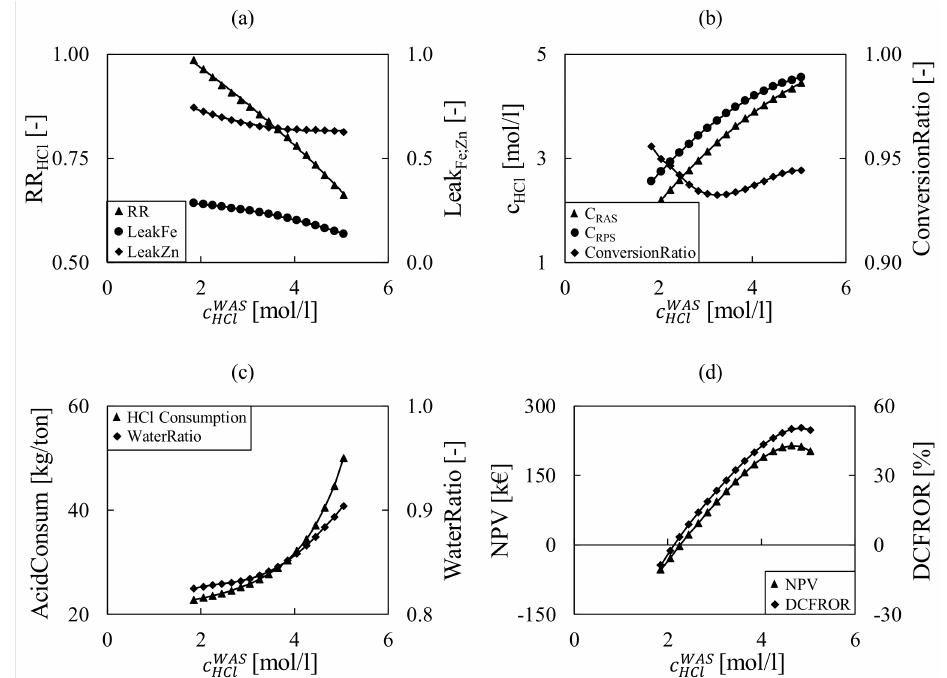
Figure 5. Sensitivity analysis with c WAS for the key variables in the DD ( a ), MD ( b ), Pickling and HCl Integrated Process ( c ) and Economic ( d ) model